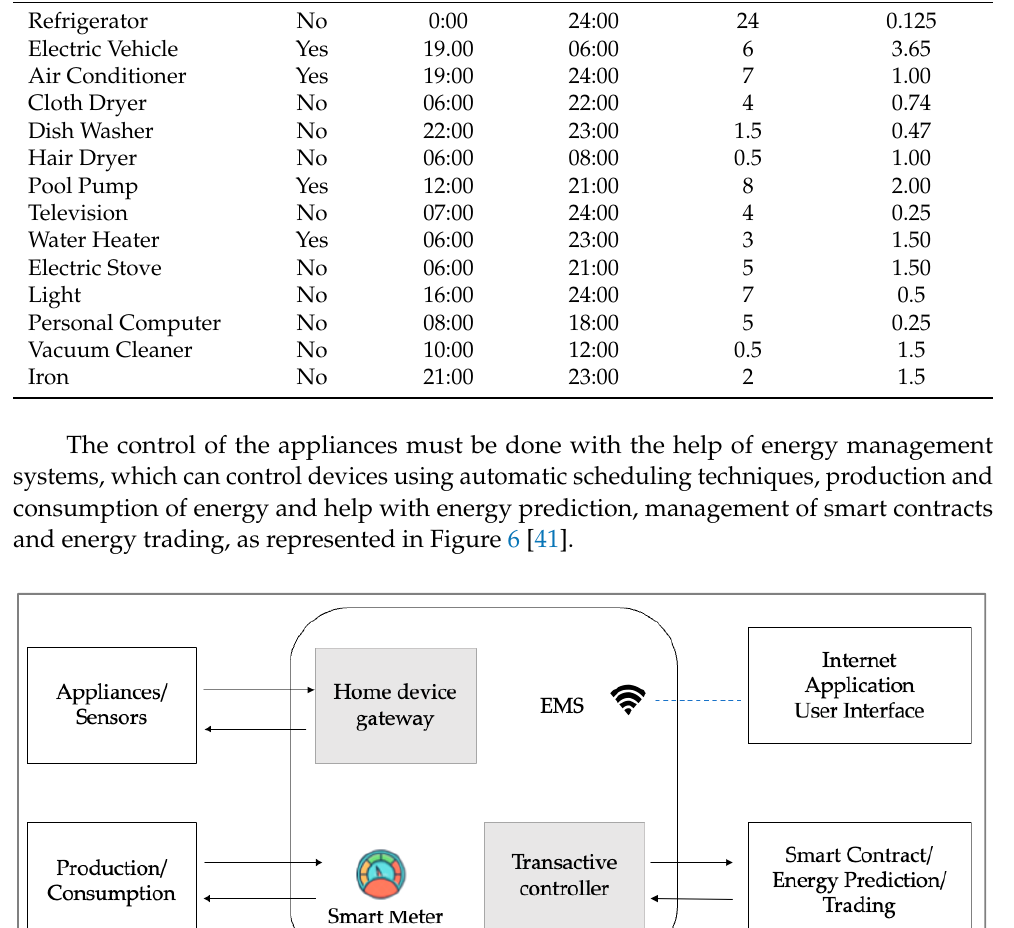
Figure 7. Power signature of a charging electric vehicle. The goal of the centralized management system is to help the management of energy demand and reduce peaks of consumption, as illustrated on Figure 8. In this way, it is possible to reduce peaks and adapt consumption, thus making a better management of the grid [48]. Using smart relays to toggle appliances on and off when there is a need to adjust the electrical power grid load allows the system to intervene and, for instance, to start the charging of electric vehicles at night or change the charging schedule. It is im- portant to evaluate possible peak hours using data from Table 9 and adjust the schedule accordingly. When the energy load within a neighborhood is not balanced, the system evaluates each household individually to determine where the smart balancing measures should be applied.